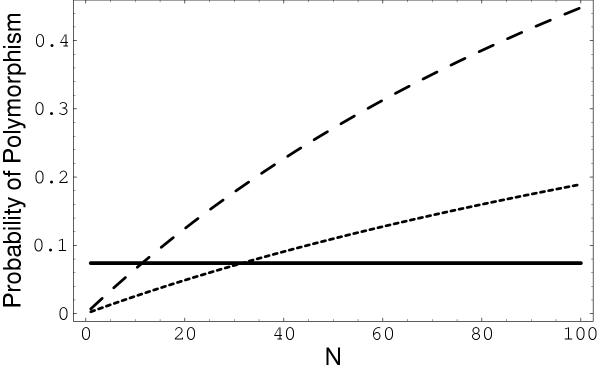
Probability of detecting polymorphism in the absence of selection, as a function of N. Two different ranges of detectable polymorphism were used. Dashed curve: (0.1, 0.9); dotted: (0.3, 0.7). We use μ = 7.9 × 10-4. The horizontal bar indicates the observed fraction of polymorphic populations (0.074) from de Boer et al. [22].